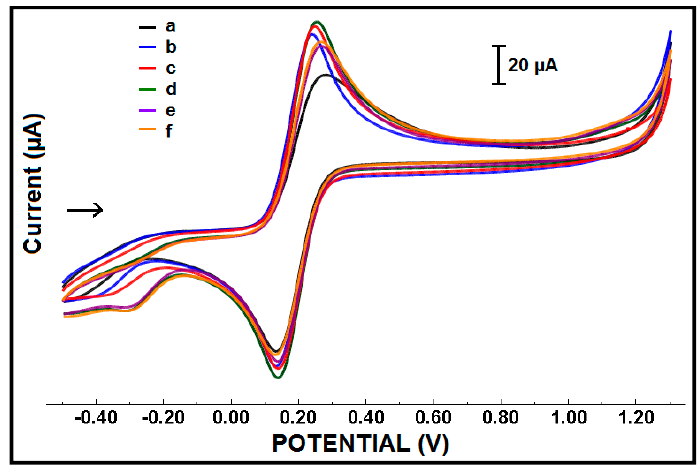
Figure 2. Cylic voltammograms of (a) PGE, (b) ILPGE, (c) 25 µ g/mL CoPc-IL-PGE, (d) 50 µ g/mL CoPc-IL-PGE, (e) 100 µ g/mL CoPc-IL-PGE, and (f) 200 µ g/mL CoPc-IL-PGE in the presence of 5% IL. Table 1. The average values (n = 3) of anodic peak current (I a ), the cathodic current (I c ), the anodic charge (Q a ), and the cathodic charge (Qc) obtained by using PGEs, IL—PGEs, and CoPc—IL modi- fied PGEs in various concentration of CoPc.